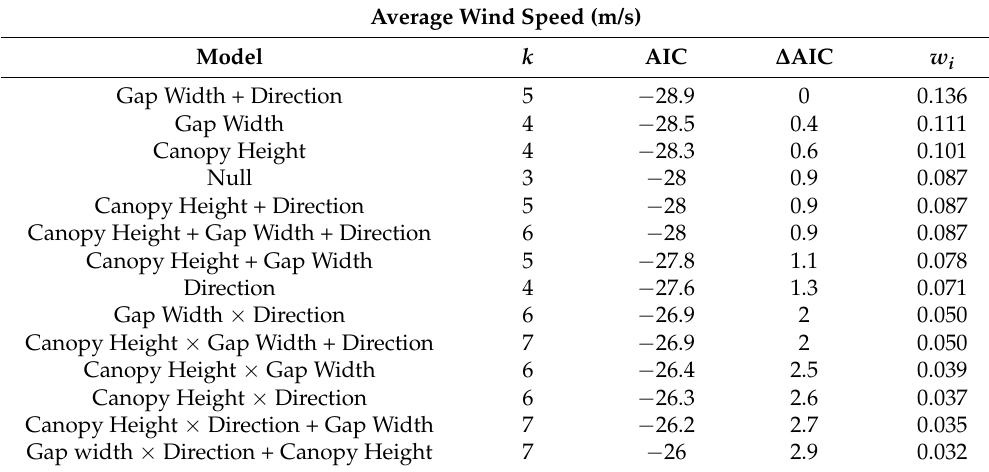
Table A2. Generalized Linear Mixed Models for average wind speed along seismic lines. Models with combinations of canopy height, gap width, and line orientation that are more supported than the null model are shown here. Model results are in ascending order of AIC weight. Number of parameters ( k ), delta AIC, and likelihood of the model based on Akaike weights ( w i ) are reported.